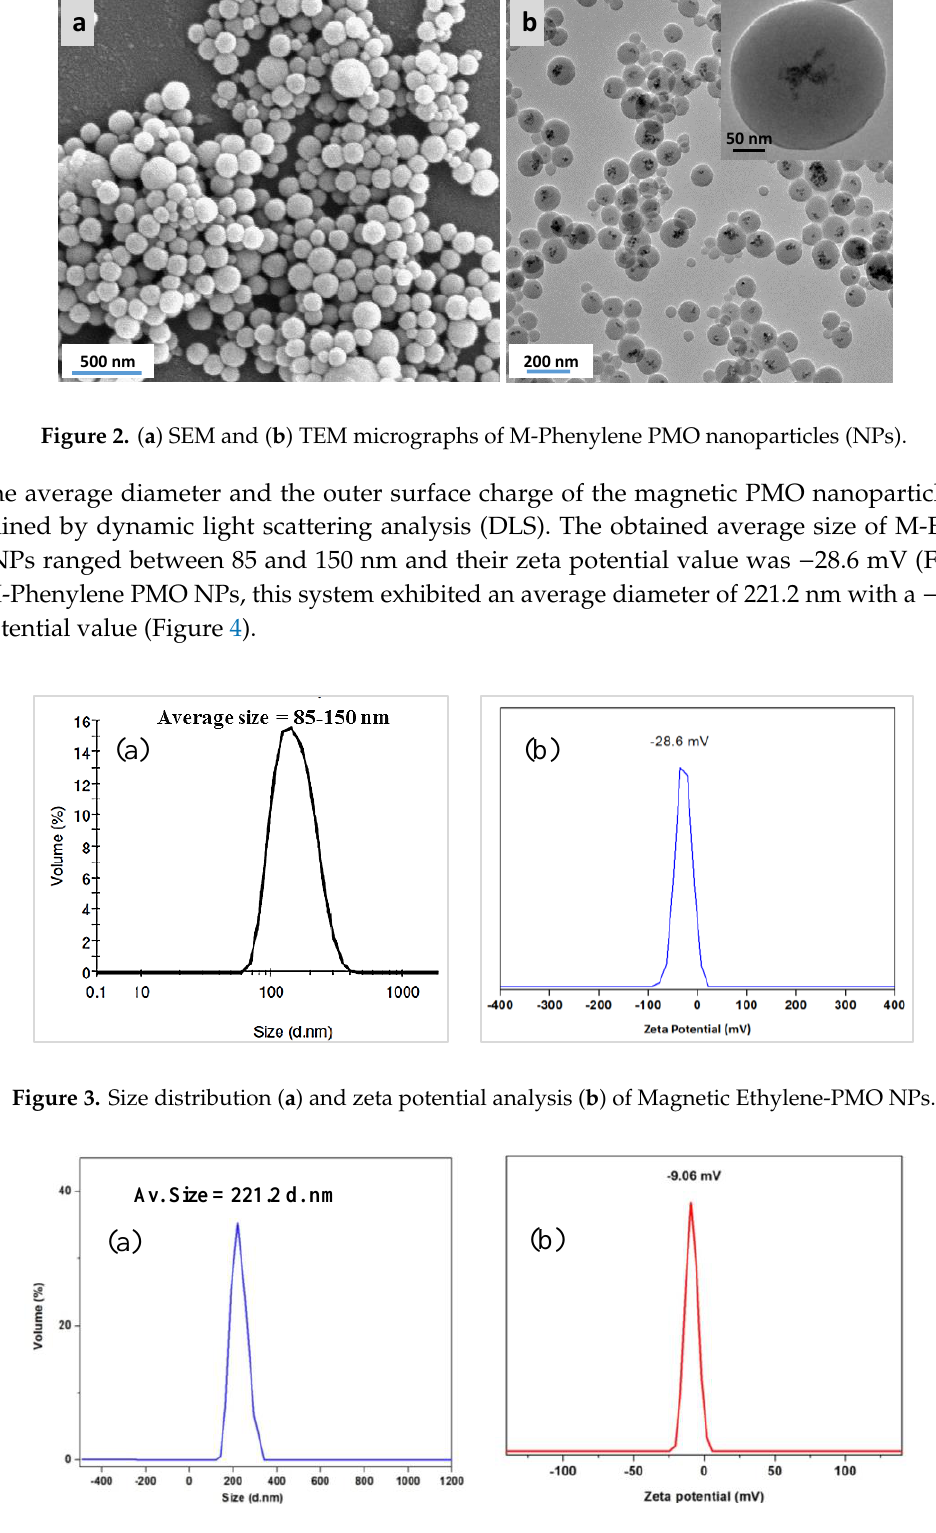
Figure 4. Size distribution ( a ) and zeta potential ( b ) analysis of Magnetic Phenylene-PMO NPs .